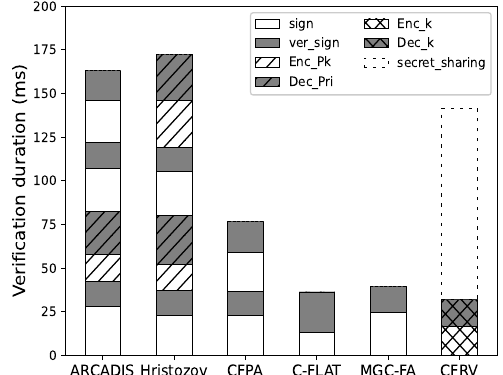
Figure 11. One round of attestation.